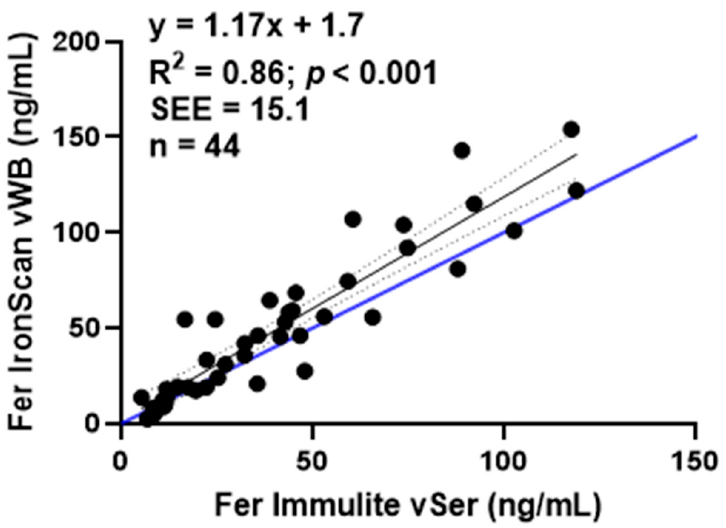
Figure 3. Comparison of ferritin (Fer) values from IronScan™ using venous whole blood (vWB) versus Immulite 2000 Xpi using venous serum (vSer). Dashed lines represent 95% confidence intervals around the slope. Blue line represents the line of identity. Standard error of the estimate, SEE.